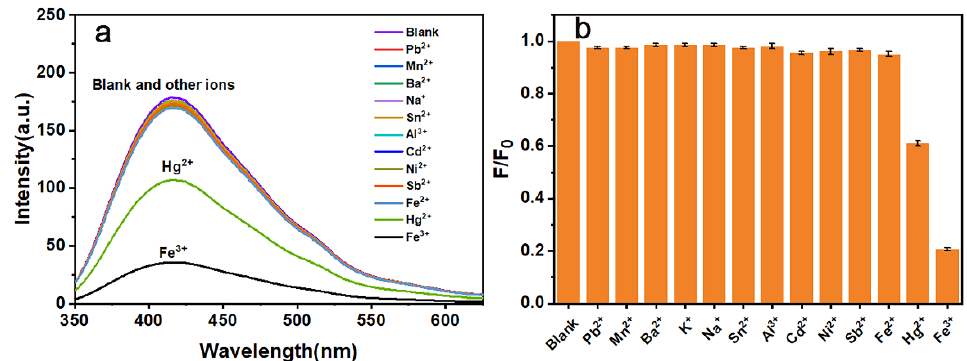
Figure 8. Fluorescence emission spectra ( a ) and relative intensities at 417 nm ( b ) of N-CQD-13 treated with different metal ions (500 μM).